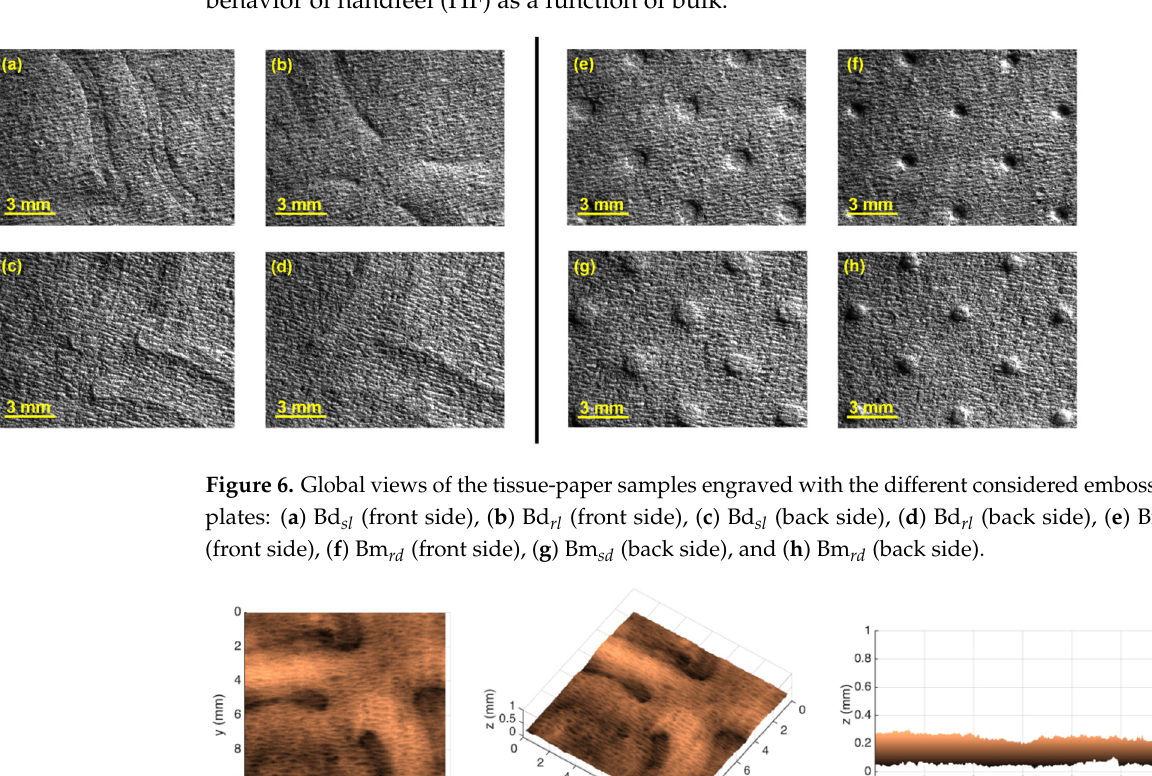
Figure 5. Results of mechanical characterization and bulk obtained for all the embossed samples and the reference paper, B, for the different finishing geometries of the 3D steel plates.